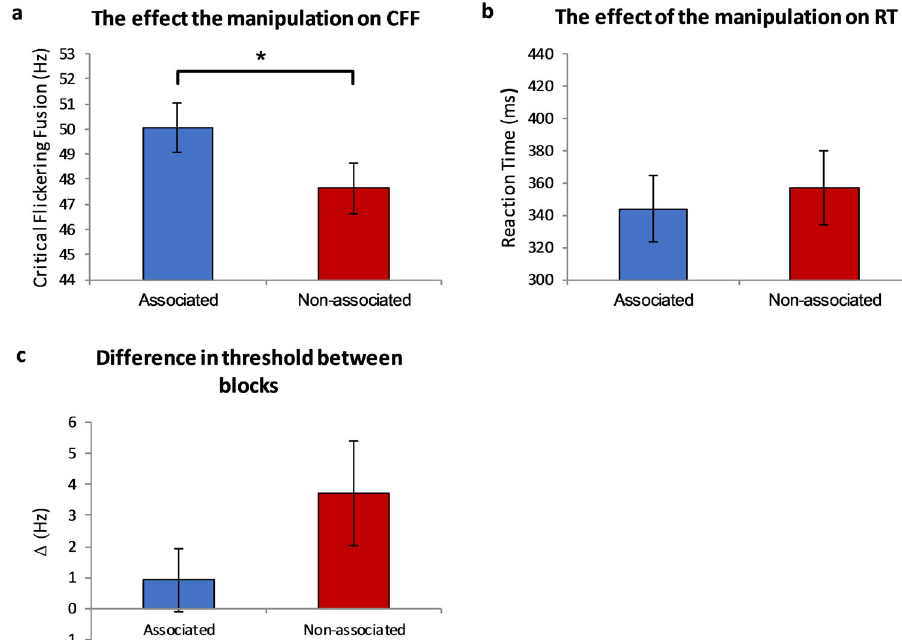
Fig. 6 Critical fl icker fusion results. a The mean CFF threshold in the associated block was higher than in the non-associated block indicates better visual performance. The results in Hz units. b No differences were found in reaction times between conditions. c No signi fi cant difference was found in the difference of threshold between the blocks indicate that the starting block did not affect the results. Blue, Associated block; Red, Non-associated block. Error bars indicate the standard error of the mean, and asterisks indicate signi fi cant differences between conditions (* p <